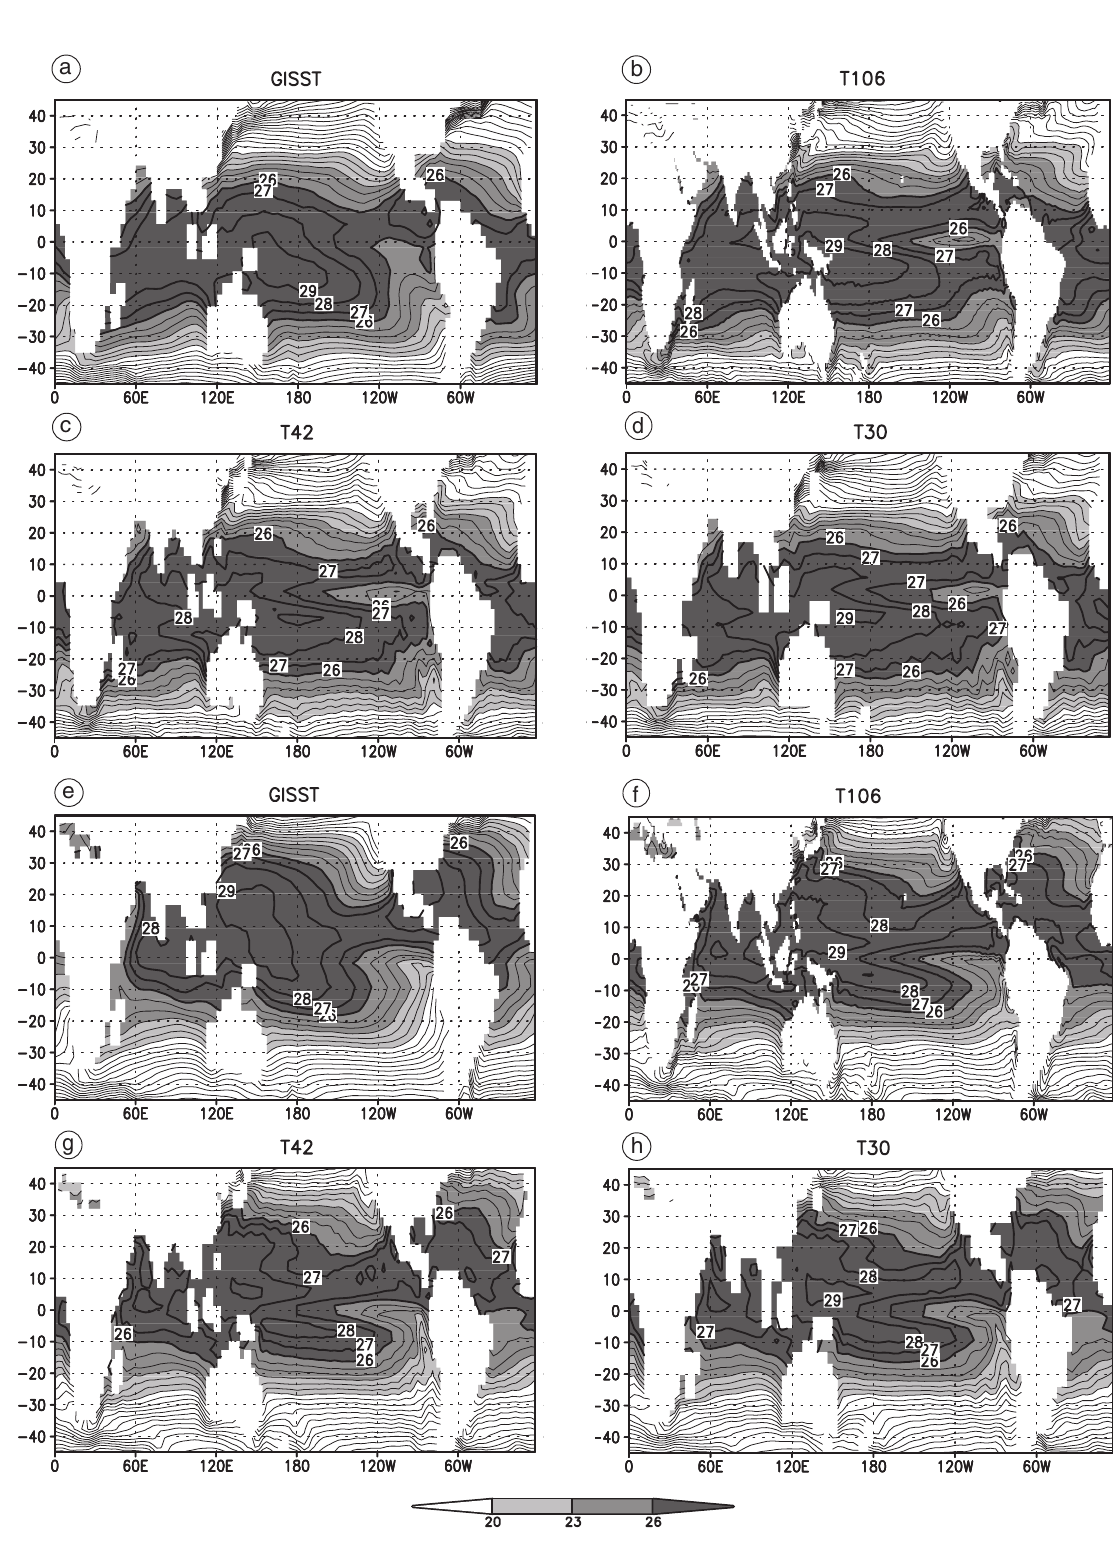
Fig. 2a-h. Mean SST fields. Panel a) and panel e), as derived from the GISST data set for the northern winter (JFM) and northern summer (JAS) respectively; panel b) and panel f), as derived from the T106 experiment for JFM and JAS respectively; panel c) and panel g), as derived from the T42 experiment for JFM and JAS respectively; panel d) and panel h), as derived from the T30 experiment for JFM and JAS respectively. Contour line interval is 1 ° C; shaded contour interval is 3 °